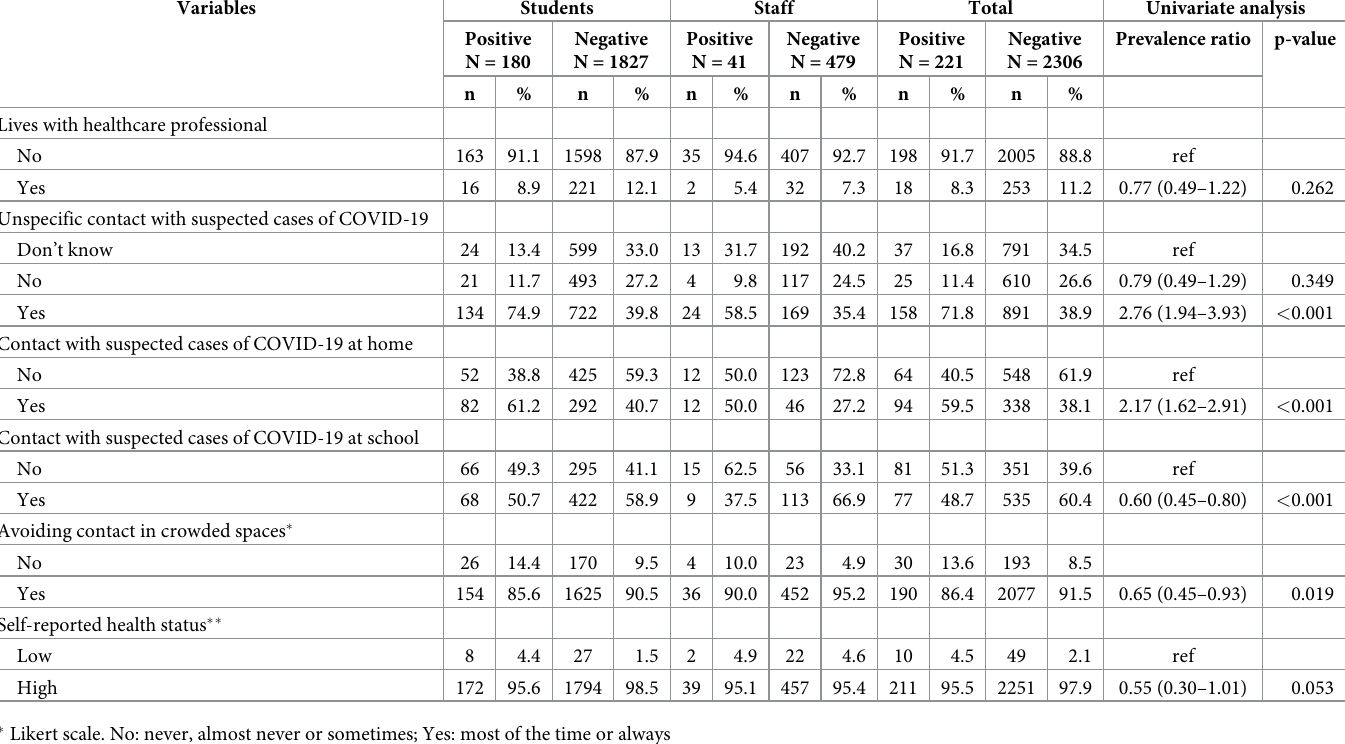
Table 7. Univariate analysis between SARS-CoV-2 infection and contact patterns of students and staff from sentinel schools. Catalonia, Spain, February-March 2021. Variables